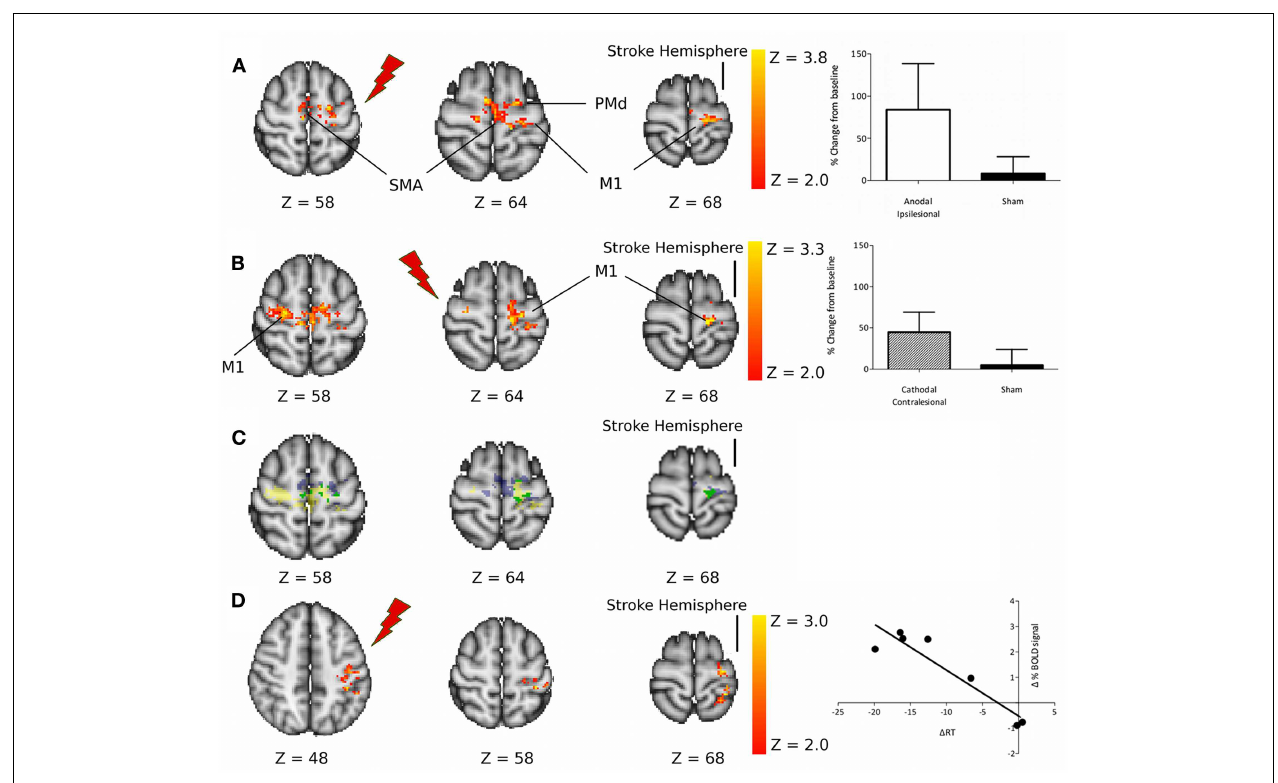
M1 Ipsi anodal tDCS (blue), M1 Cont Cathodal tDCS (yellow), and regions where these two effects overlap (green). (D) Regions of significant correlation between the change in motor-related fMRI signal due to M1 Ipsi anodal tDCS and the tDCS-induced change in reaction times. M1, primary motor cortex; SMA, supplementary motor area; PMd, dorsal premotor cortex. Reprinted with permission from Figure 3, Stagg et al.